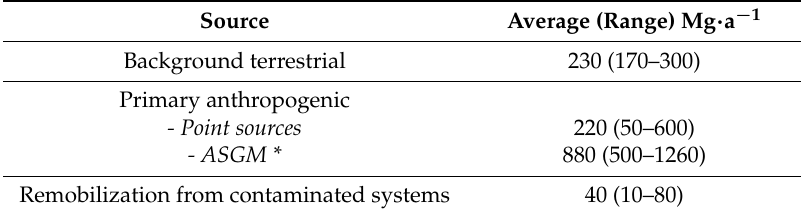
Table 1. Summary of release estimates from various Hg sources to freshwater aquatic environments